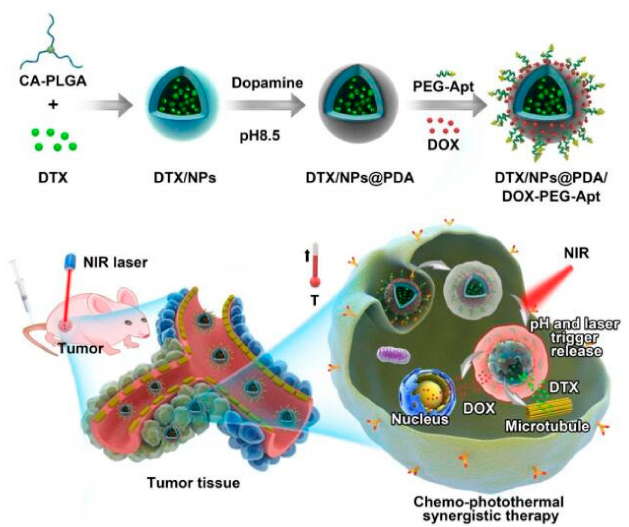
Figure 1. Schematic illustration of docetaxel (DTX) / polymeric nanoparticles (NPs)@polydopamine (PDA) / doxorubicin (DOX)-polyelethyl glycol (PEG)-Aptamer (Apt) for targeted dual chemo and photothermal synergistic cancer